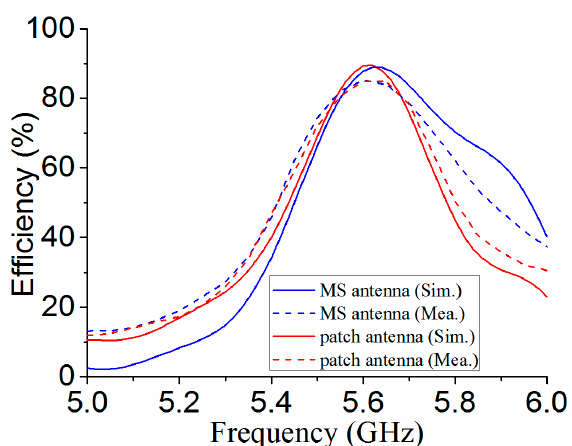
Figure 12. Simulated and measured efficiencies for patch antenna and MS antenna.